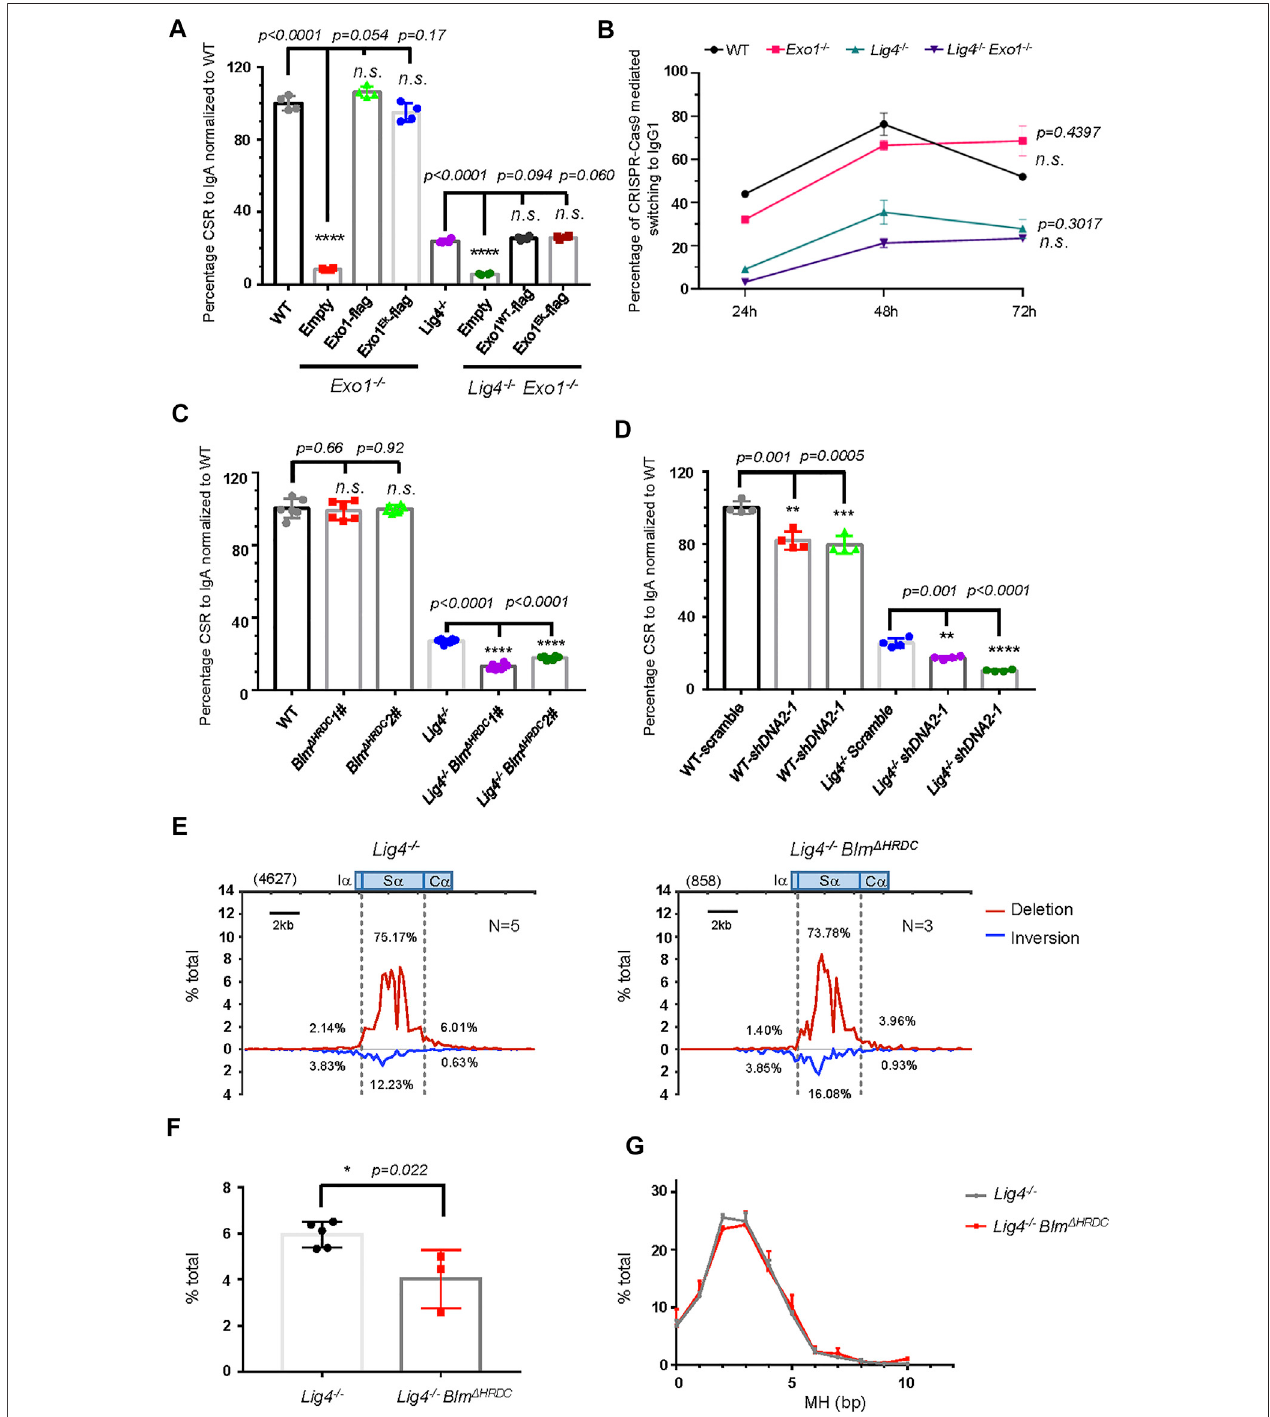
FIGURE3| Long resection factorsBLM/DNA2 areinvolvedinA-EJmediatedCSR. (A) NormalizedCSRtolgAinExo1-de fi cient Bcellreconstitutedwithretrovirus expressing indicated constructs. Data were presented as mean ± SD from four independent experiments (Student ’ s t -test, * p < 0.05, ** p < 0.01, *** p < 0.001, **** p < 0.0001, n. s. ( p > 0.05) indicates non-signi fi cant differences). (B) Ef fi ciency ofswitching tolgG1 with CRISPR/Cas9 targeting S μ and S γ 1, respectively, in Exo1-de fi cient WT and Lig4 − / − cells. Data were presented as mean ± SD from three independent experiments (two-way ANOVA, n. s. ( p > 0.05) indicates non-signi fi cant differences). (C) Normalized IgA CSR ef fi ciency in DNA2 -silenced WT and Lig4 − / − cells. Data were presented as mean ± SD from four independent experiments (Student ’ s t -test,* p < 0.05,** p < 0.01,*** p < 0.001,**** p < 0.0001,n.s.( p > 0.05)indicatesnon-signi fi cantdifferences). (D) NormalizedIgACSRef fi ciencyin Blm